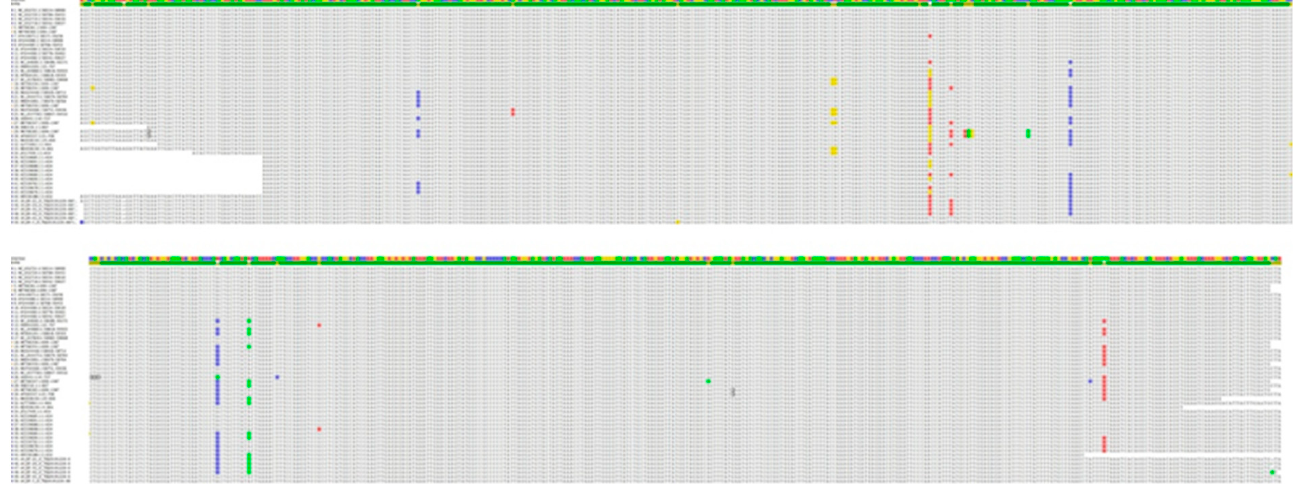
Figure 2. Multiple sequence alignment of the rbcL region of Ulmus villosa from Pakistan. Different colors indicate SNPs within the rbcL region.